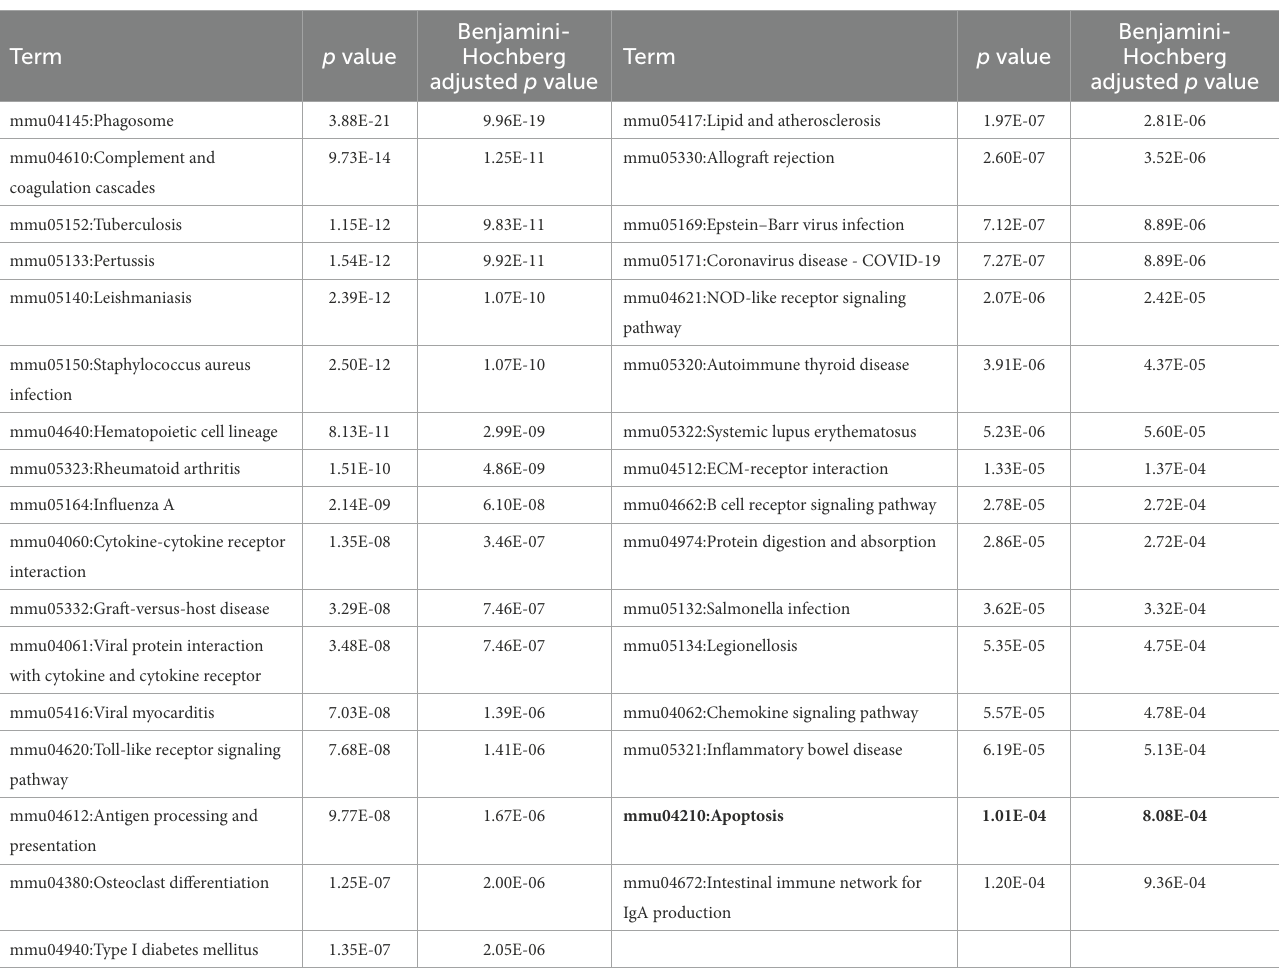
TABLE 1 Enriched kyoto encyclopedia of genes and pathways in the very early exposure to EE group.